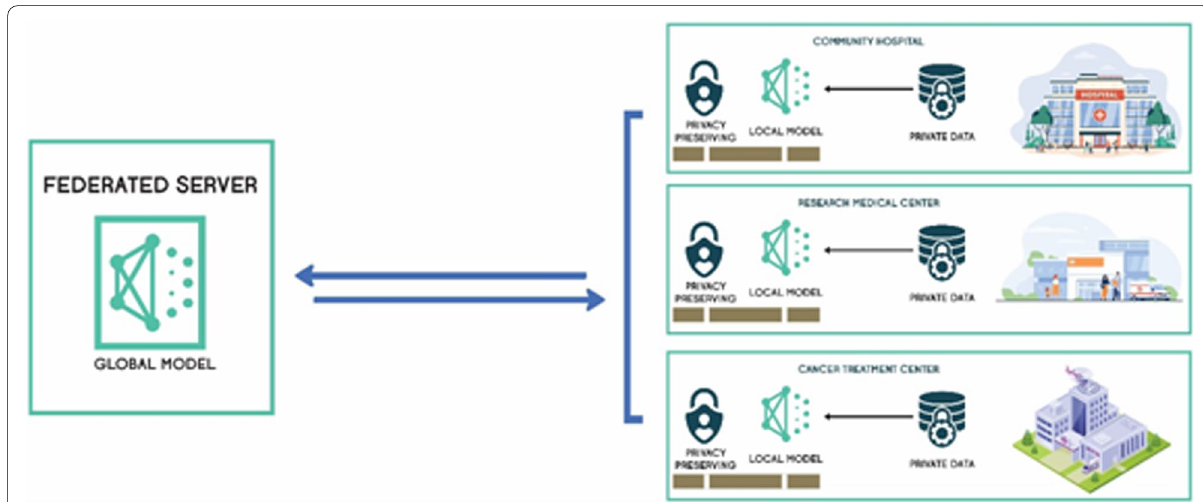
Fig. 1 The class structure of DCSO. The class structure of the DCSO Core. The class structure of the